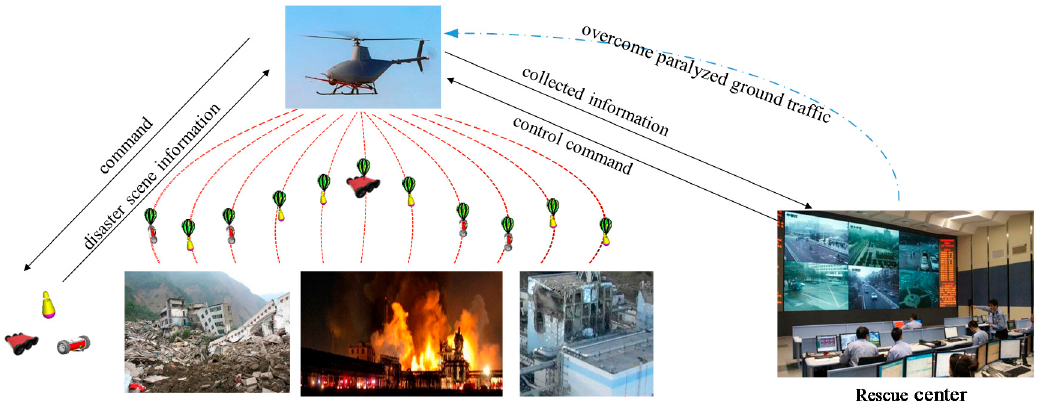
Figure 2. Disaster sensing mode using MSADM.